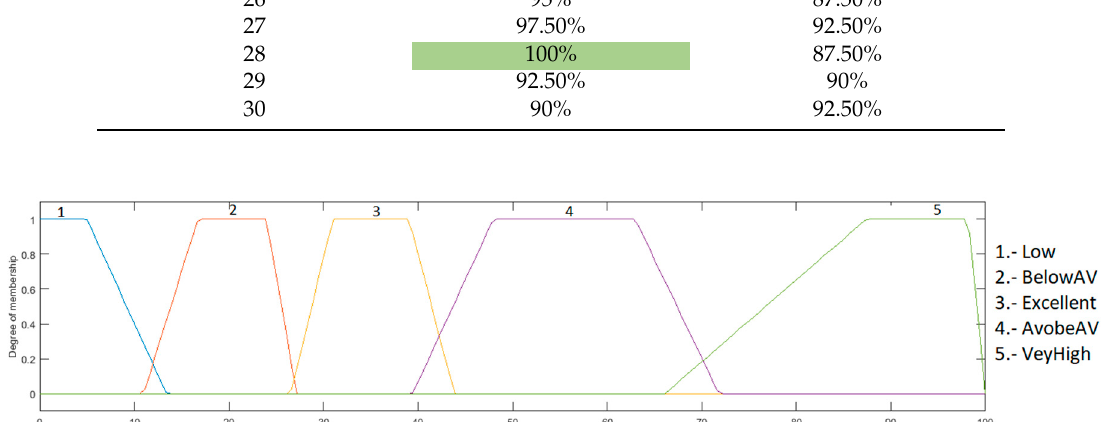
Figure 21. Optimized output heart rate level.